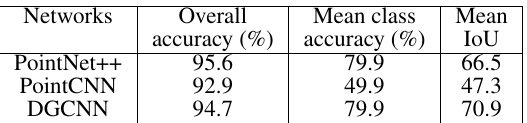
Table 2. Class IoUs of each